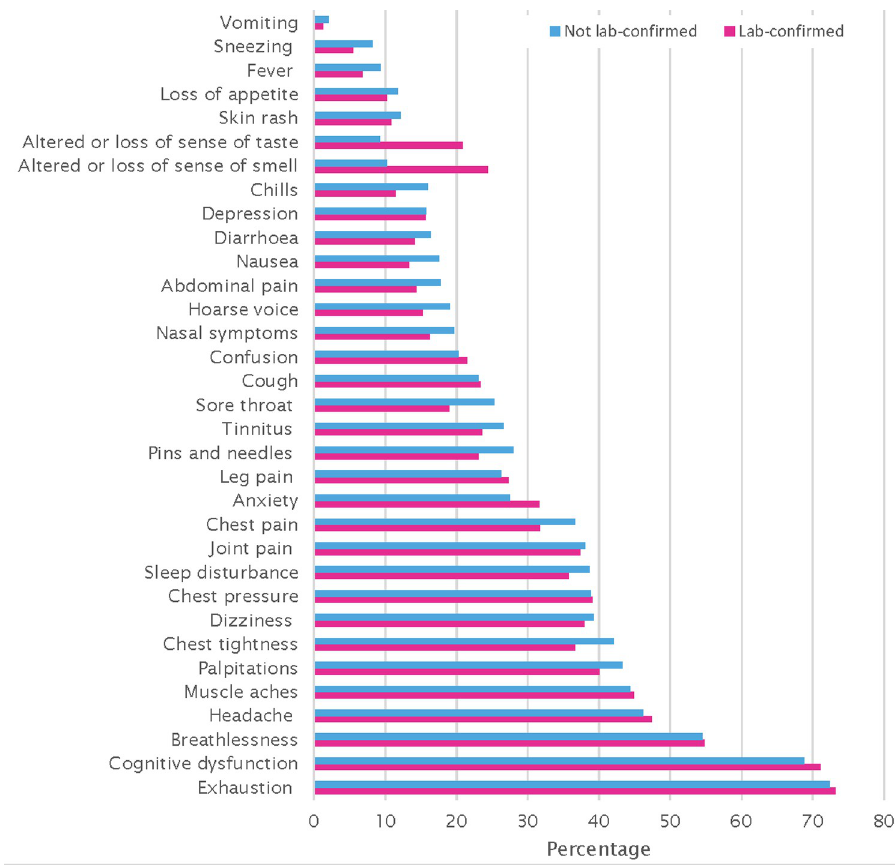
Fig 1. Frequency of reported ongoing symptoms in survey participants (n =